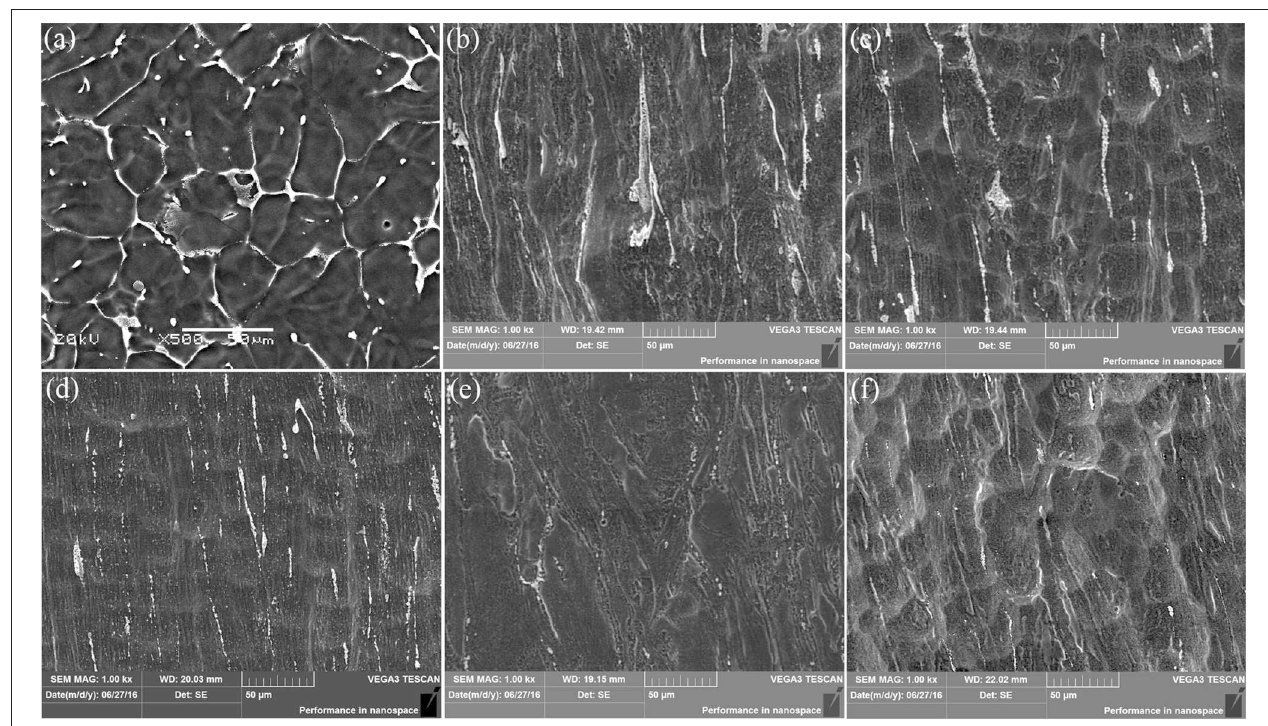
FIGURE 13 | SEM micrographs showing the corroded Mg-2.0Zn-0.5Zr-3.0Gd samples after immersion for 120h and corrosion product removal: (a) As-cast; (b) E330; (c) E340; (d) E350; (e) E360; (f) E370.